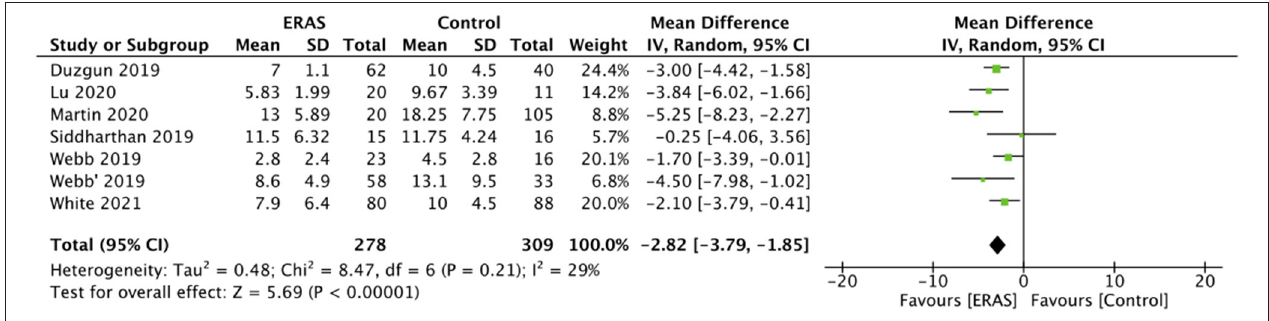
FIGURE 2 | Meta-analysis for LOS between ERAS and control